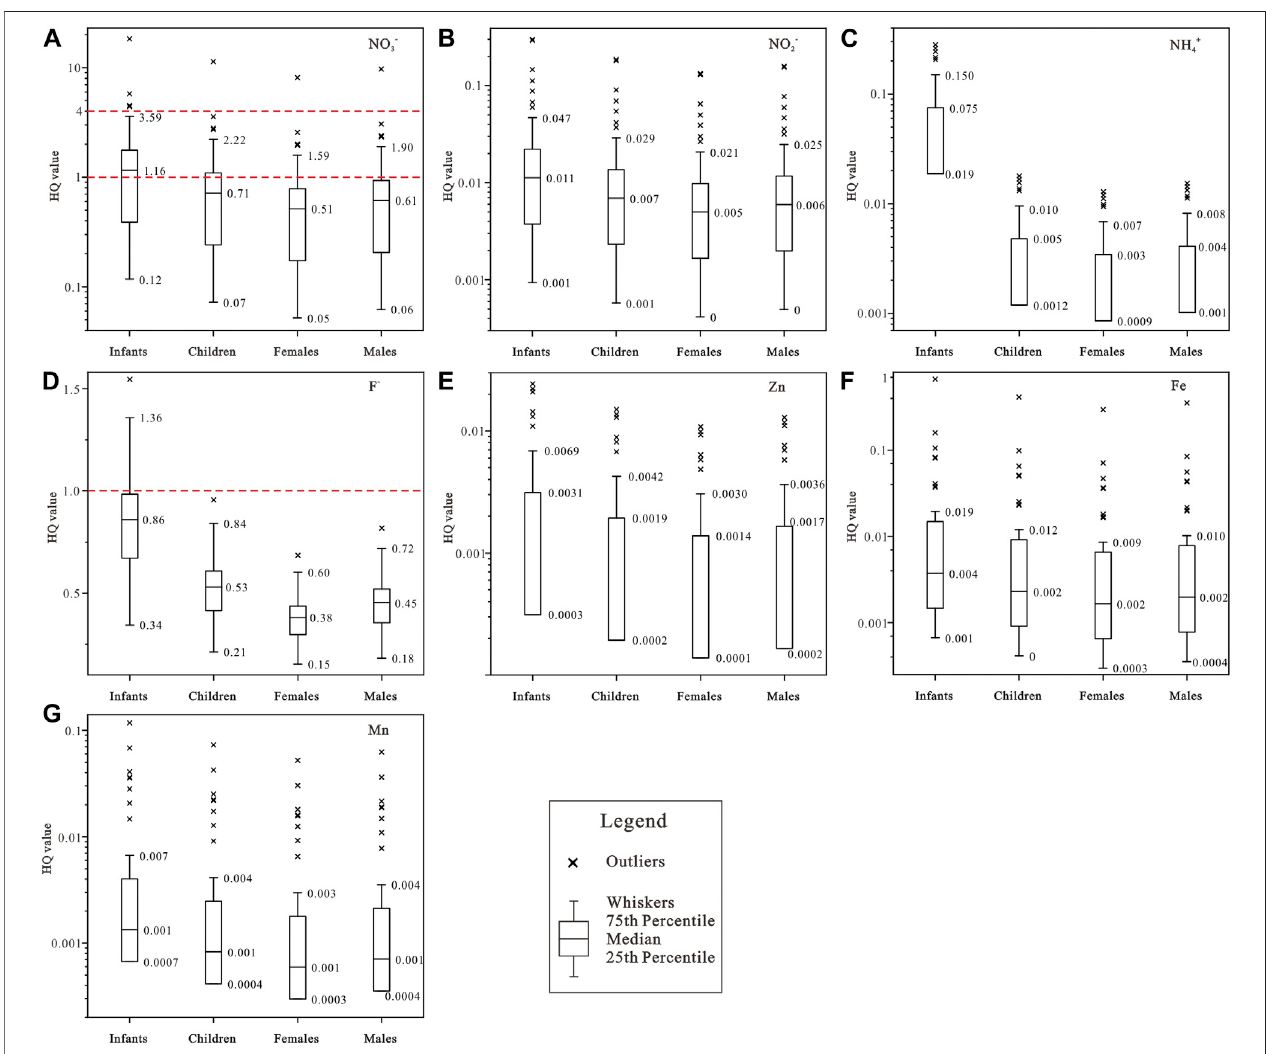
FIGURE 8 | Box plots of the hazard quotient of noncarcinogenic risk posed by (A) NO 3 − , (B) NO 2 − , (C) NH 4+ , (D) F − , (E) Zn, (F) Fe, (G) Mn via oral pathway.